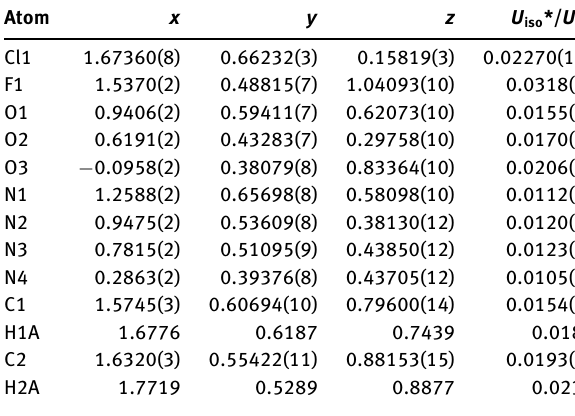
Table 2: Fractional atomic coordinates and isotropic or equivalent isotropic displacement parameters (Å 2